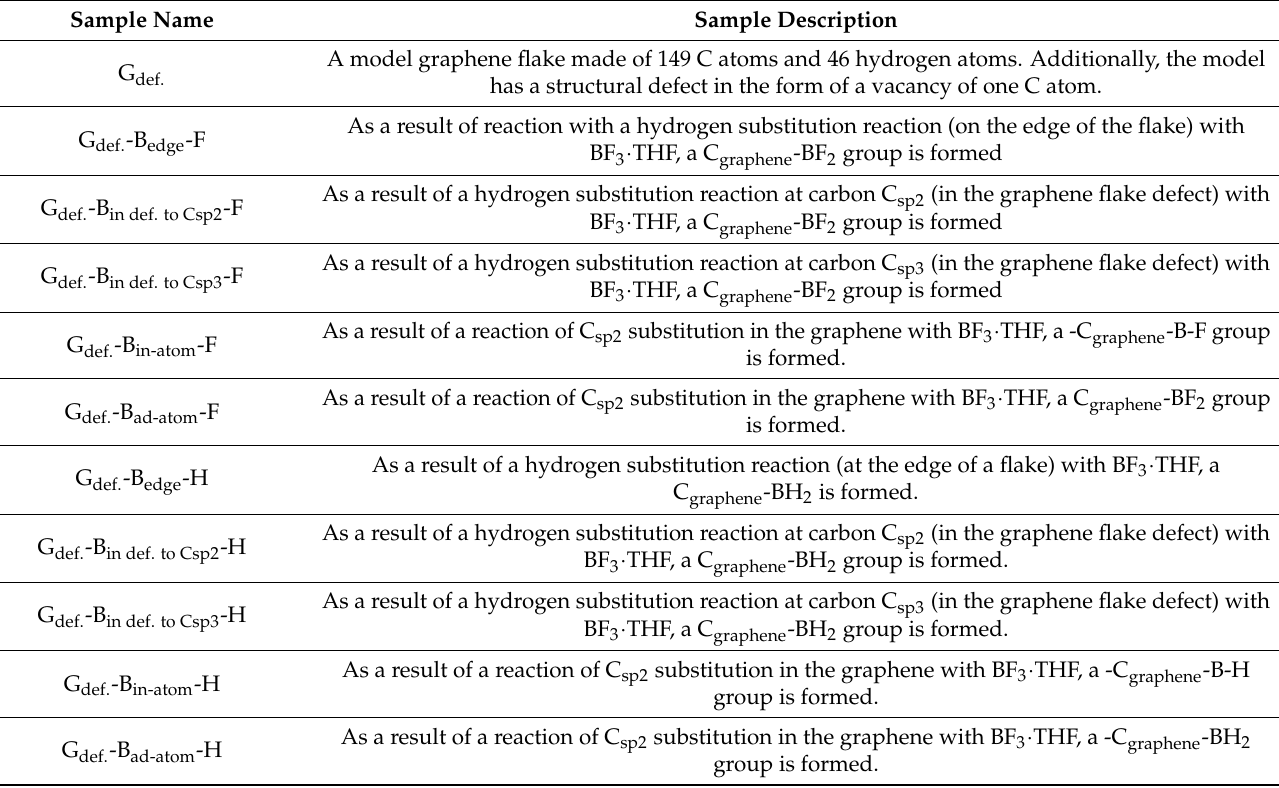
Table 2. Designations of the analyzed graphene systems depending on the place of attachment of -BF 2 groups or formation of -BH 2